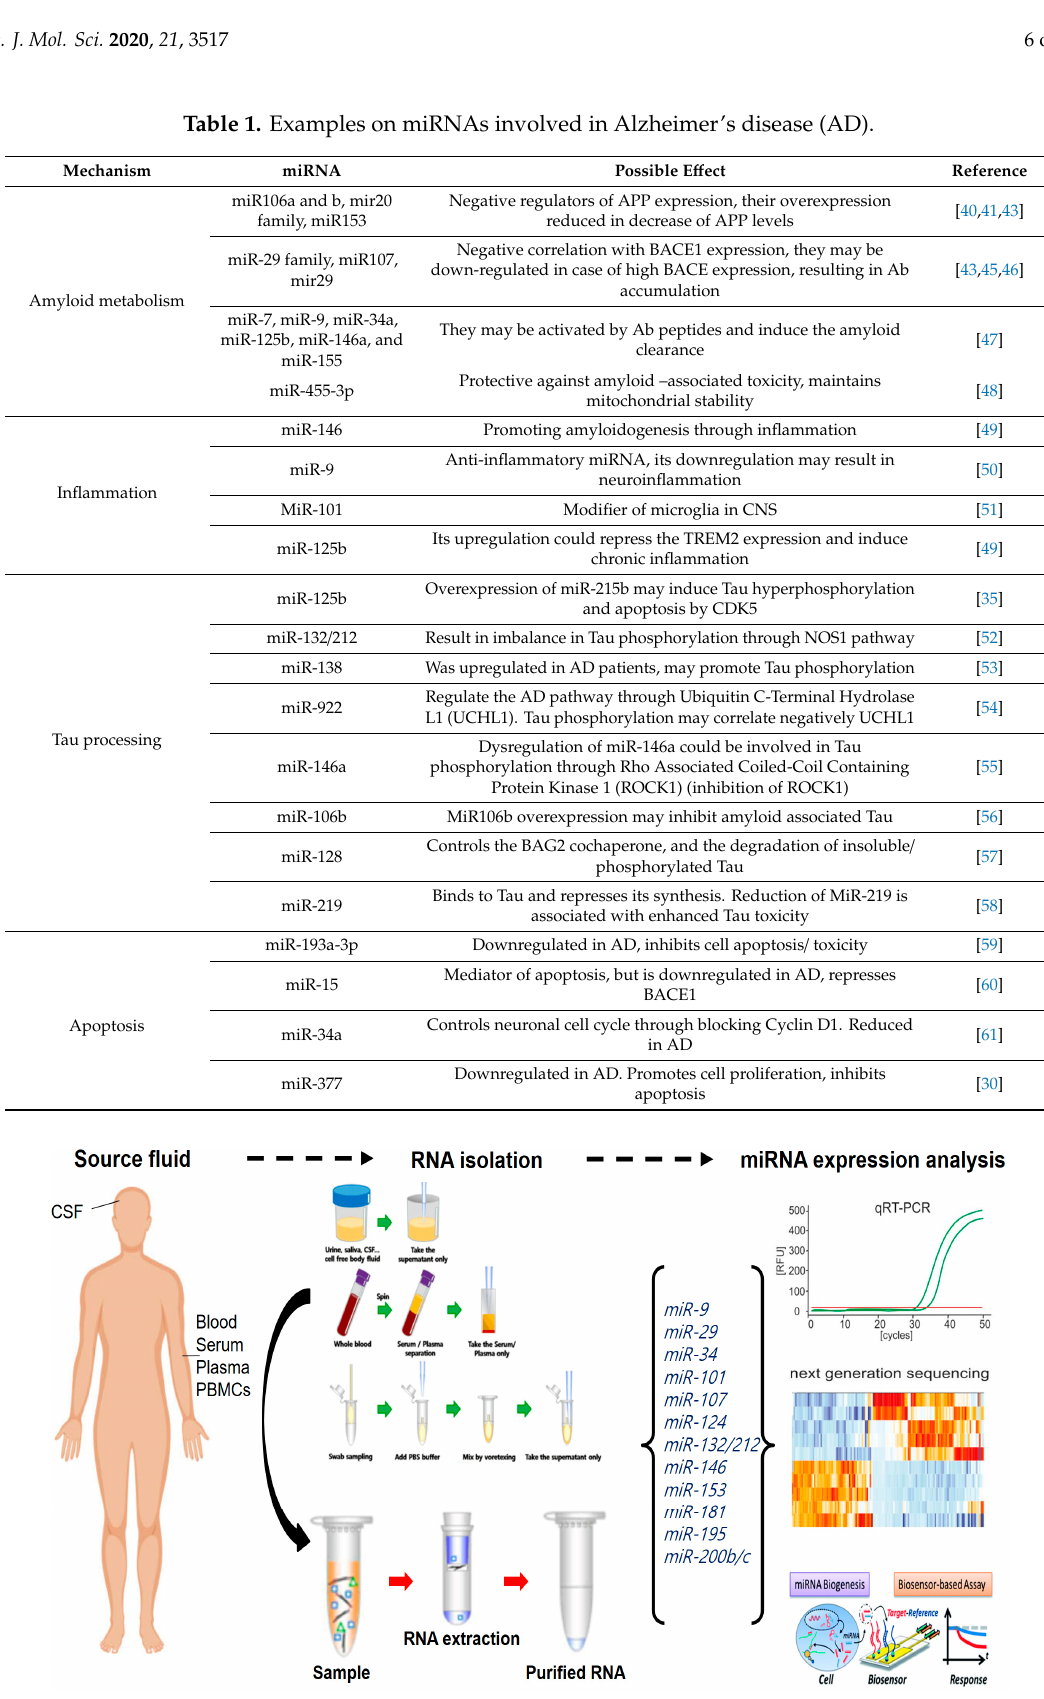
Figure 2. Methodological aspects to consider in most common miRNA biomarkers for Alzheimer’s